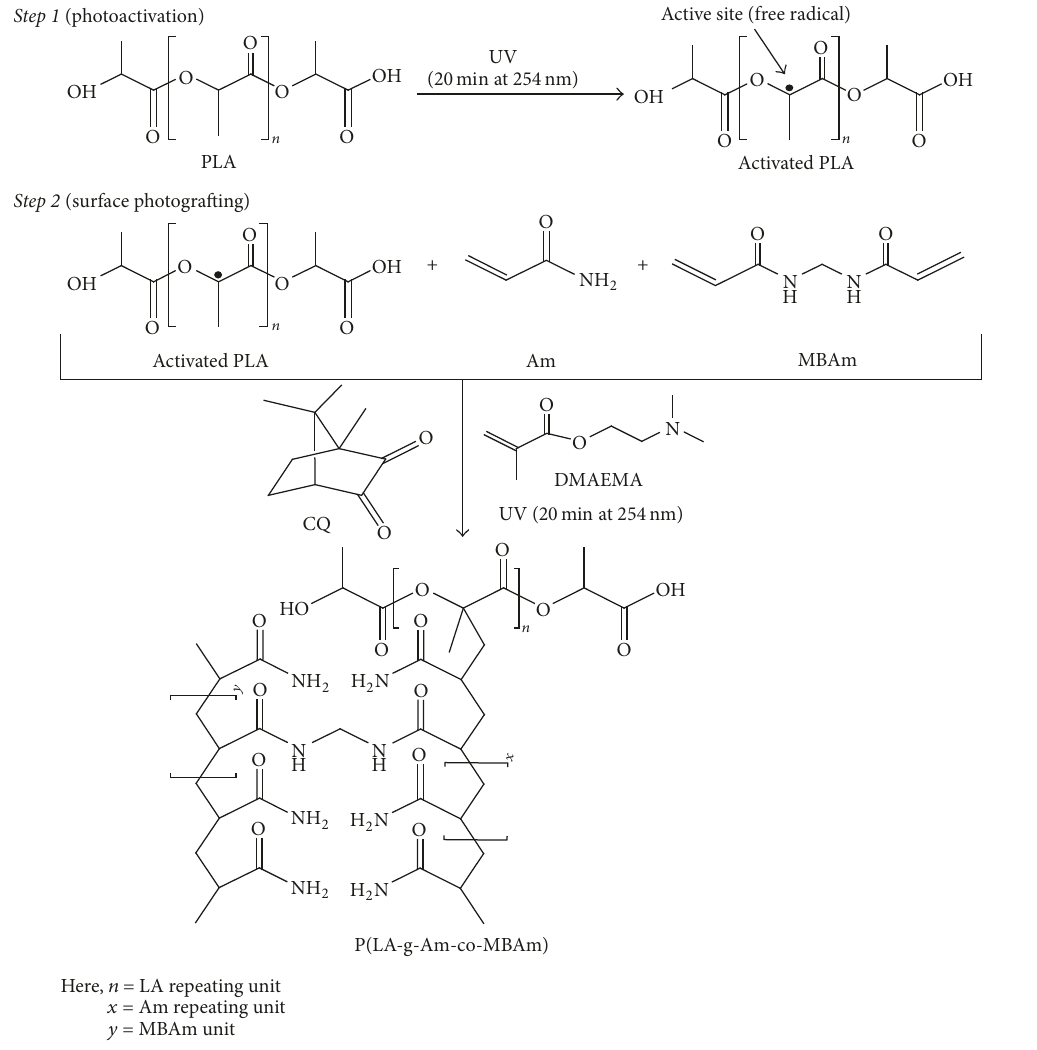
Figure 1: Synthesis route of P(LA-g-Am-co-MBAm).